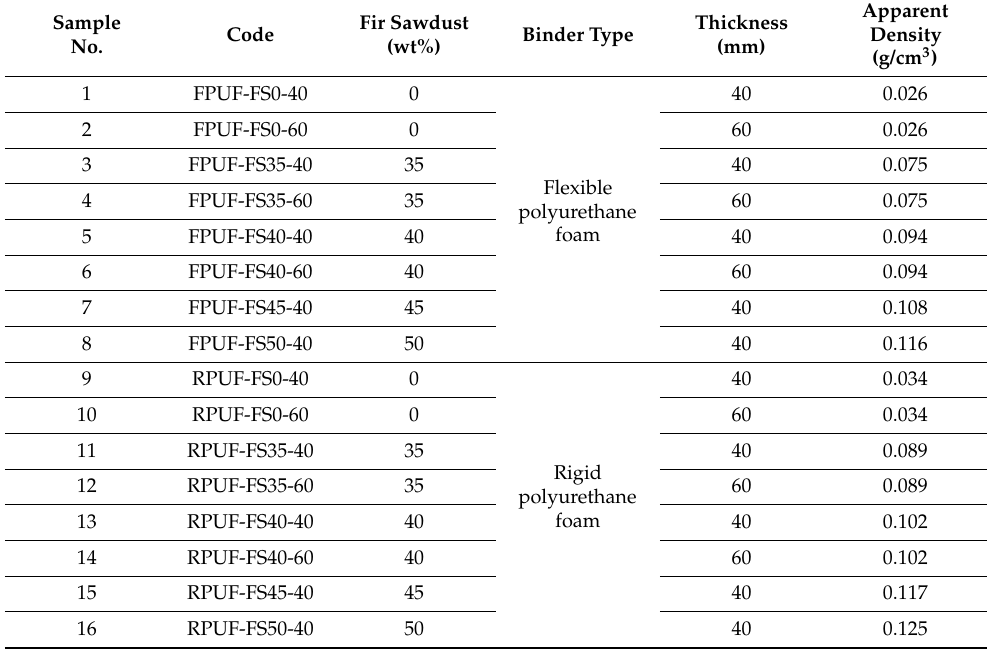
Table 1. Sample plates codification.